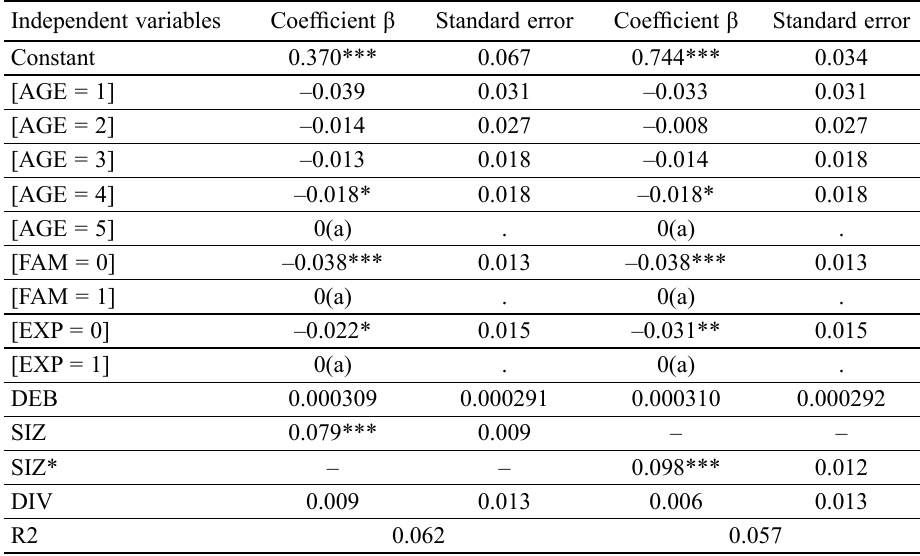
Table 7. Model 2. Dependent variable AD_HR